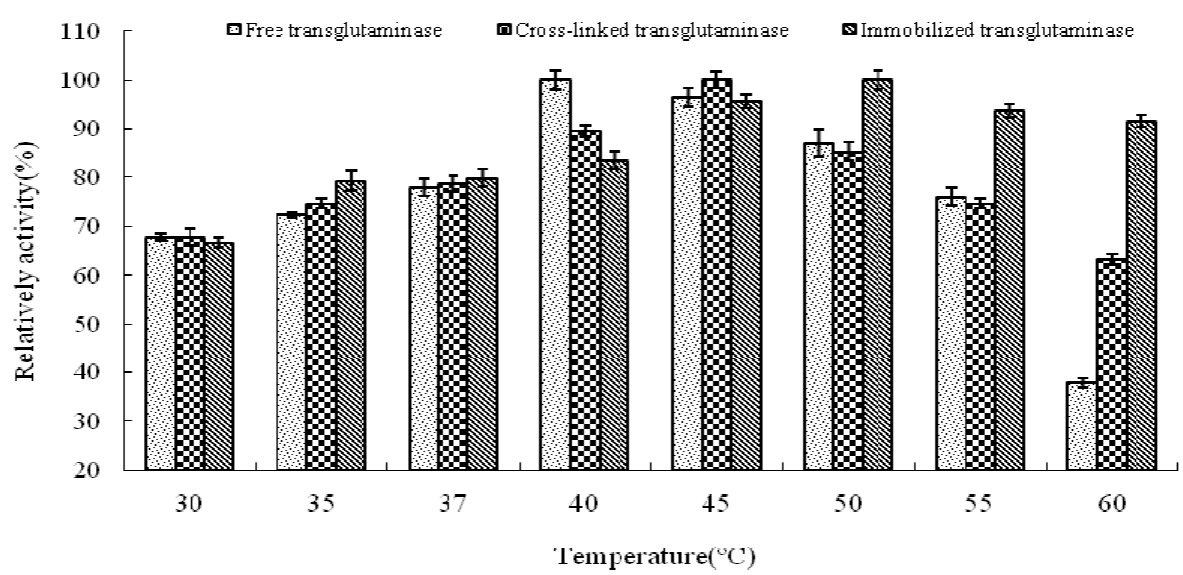
Figure 2. Temperature profile of free, cross-linked and immobilized transglutaminase. Data are expressed relative to the maximal enzyme activity.